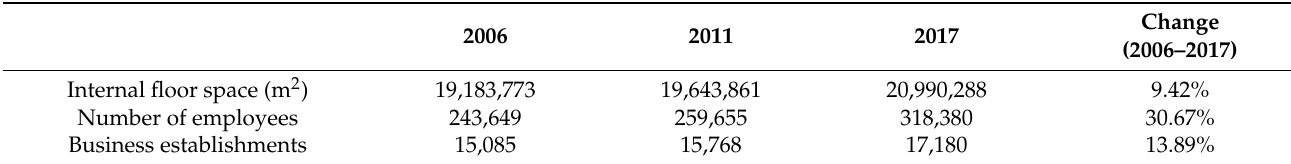
Table 1. Internal floor space, employment, and business establishment in central Sydney